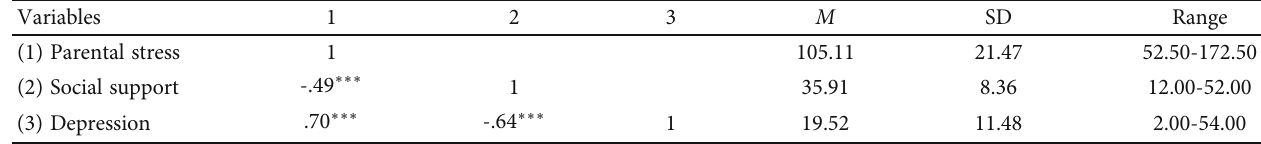
Table 3: Correlation and descriptive statistics for measured variables ( N = 164 ).